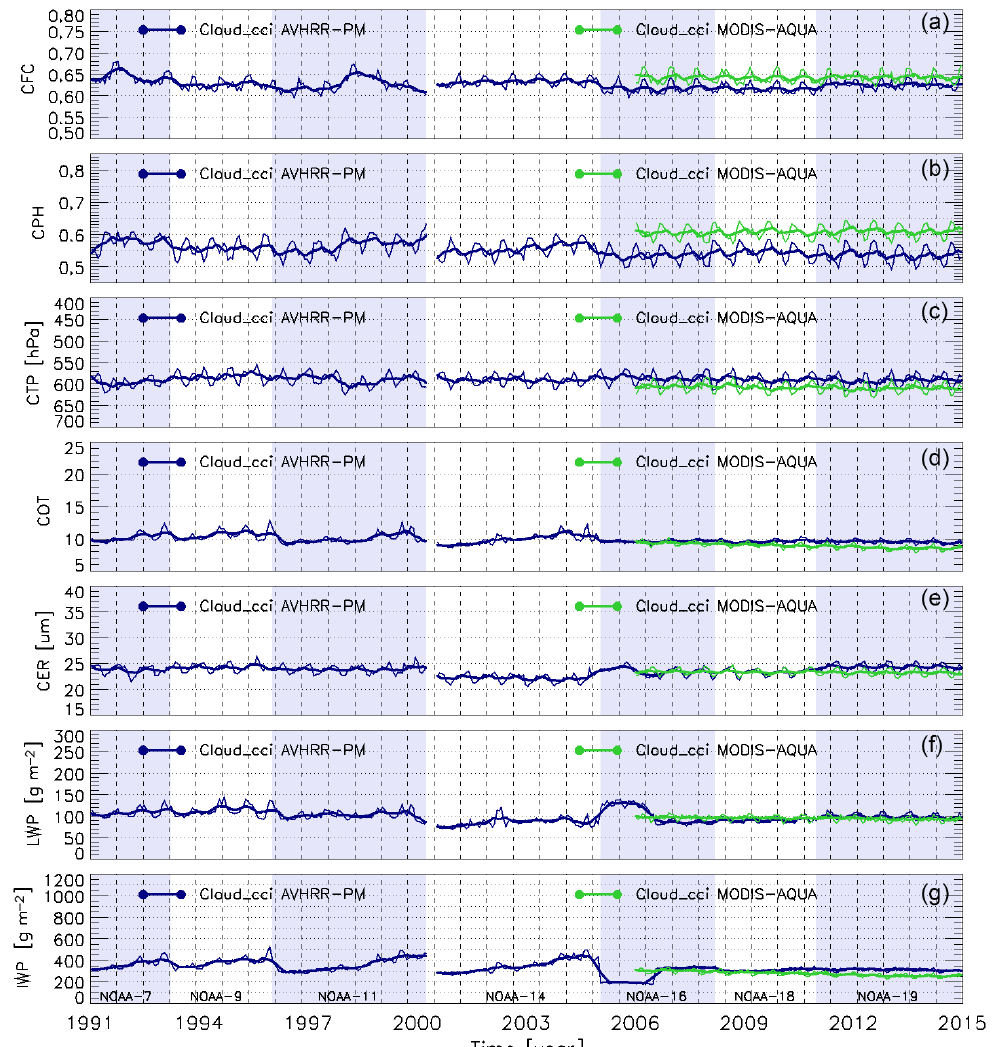
Figure 9. As Fig. 8 but for Cloud_cci datasets based on afternoon satellites. The time series shown have not been corrected for satellite drift or diurnal